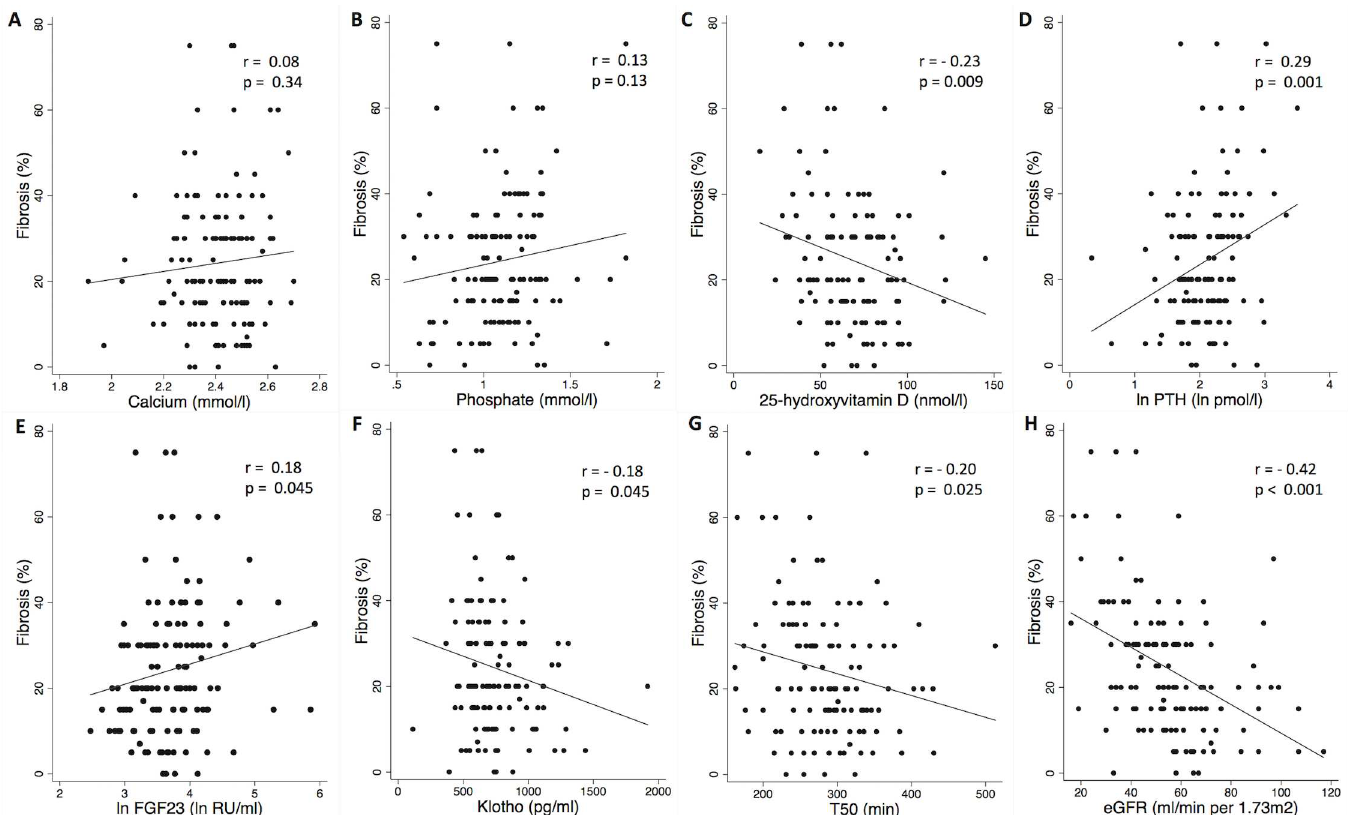
Fig 1. Correlations between phosphocalcic biomarkers, T 50 and interstitial fibrosis in renal allograft recipients (n = 129). Scatter plot graphs of (A) calcium, (B) phosphate,(C) vitamin D, (D) ln PTH, (E) ln FGF23, (F) Klotho, (G) T 50 , (H) eGFR versus interstitial fibrosis. Each symbol represents one patient. The continuous line indicatesleast-square linear regression. eGFR: estimated GlomerularFiltration Rate; FGF23: Fibroblast growth factor 23; PTH: parathyroidhormone; T 50 : Calcificationpropensity; Ln: